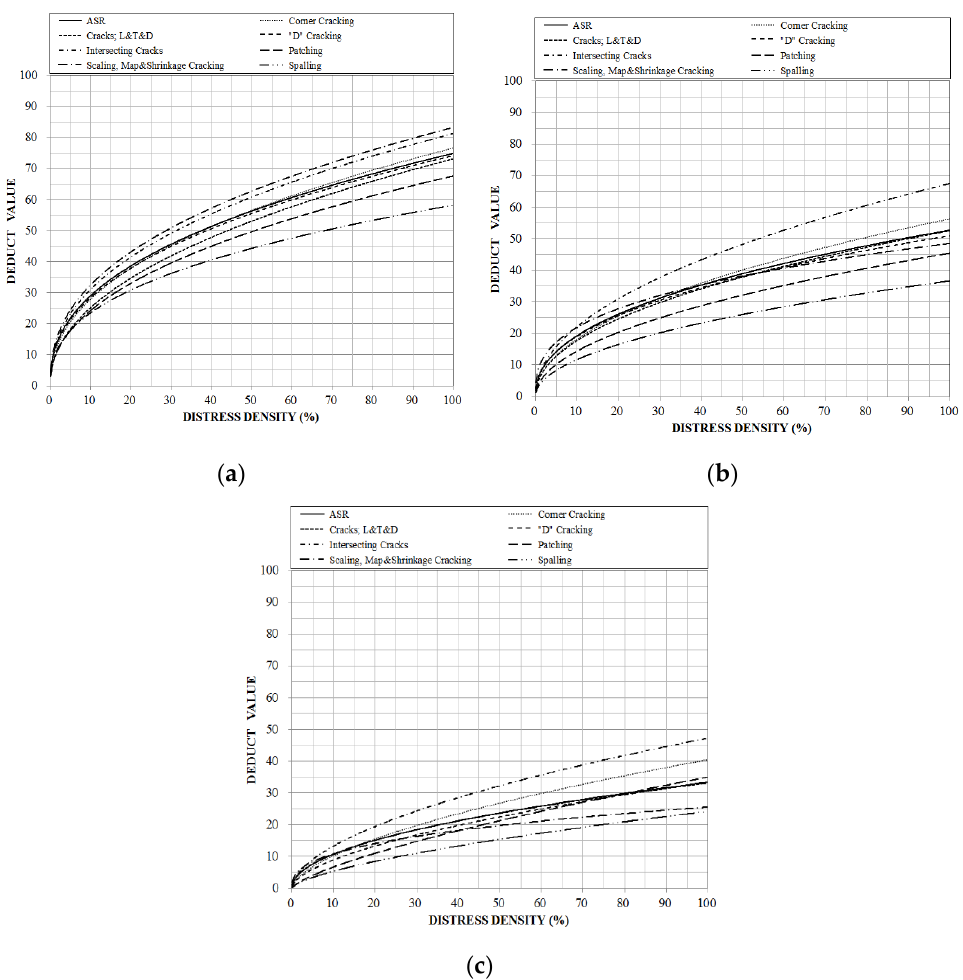
Figure 7. Developed deduct value curves of all distress types of concrete pavement at ( a ) high severity level, ( b ) medium severity level, and ( c ) low severity level.